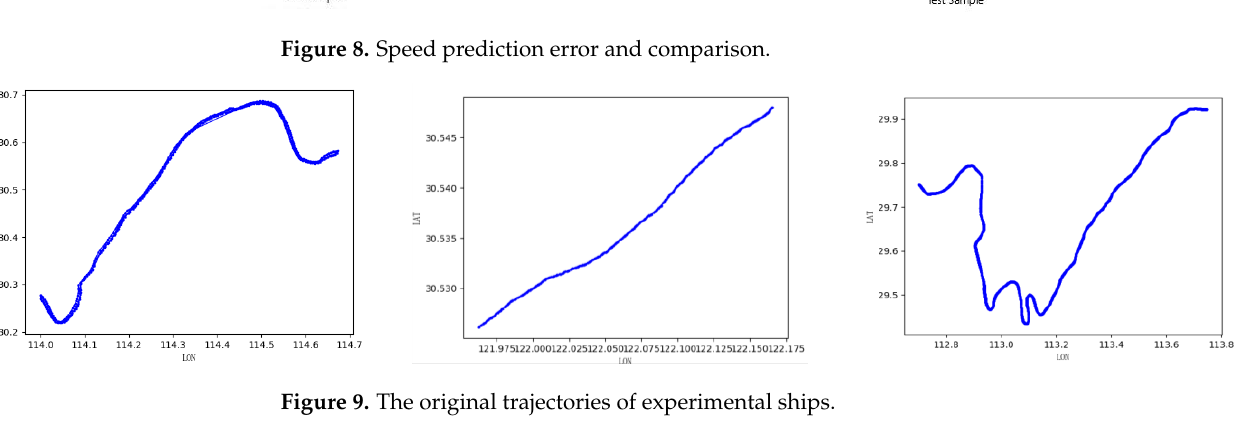
Figure 9. The original trajectories of experimental ships.